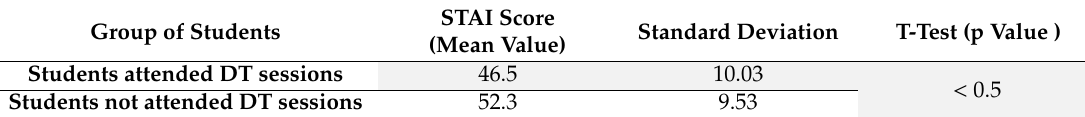
Table 2. Mean values and comparison of the State-Trait Anxiety Inventory (STAI) score of the students who attended the DT session and the students who did not attend the practical lab. The di ff erence is statistically significant.